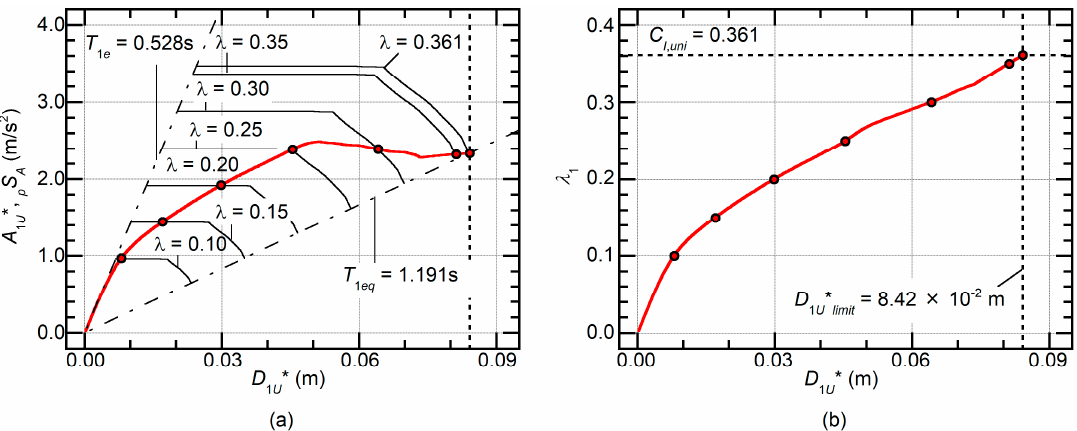
Figure 19. Evaluation of the capacity index considering the unidirectional ground motion C I, uni : ( a ) the evaluation of the peak response for each scaling factor λ , ( b ) variation of the evaluated scaling factor λ 1 corresponding to the equivalent displacement D 1 U * .